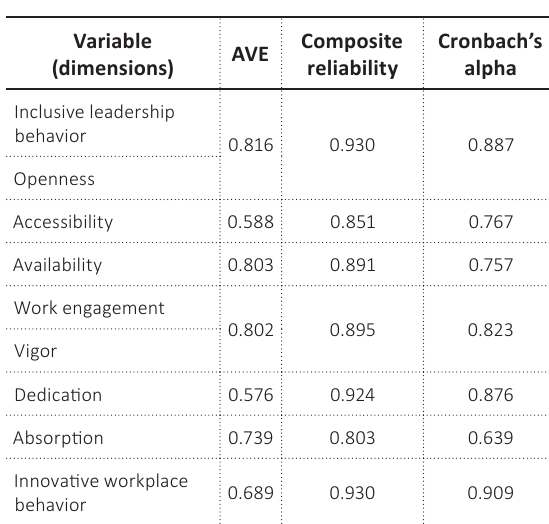
Table 3. Average Variance Extracted,